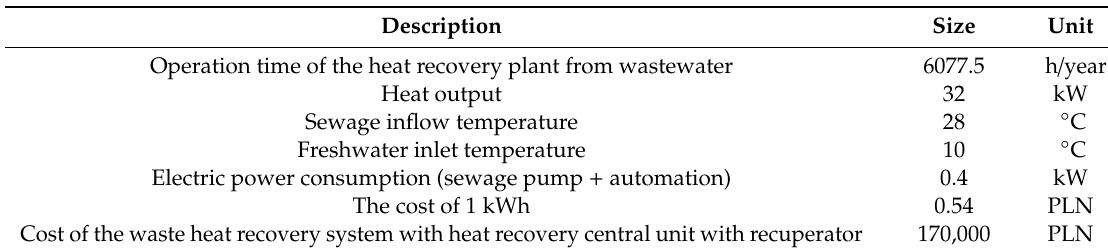
Table 5. Assumptions for the analysis of investment profitability (wastewater heat recovery center with